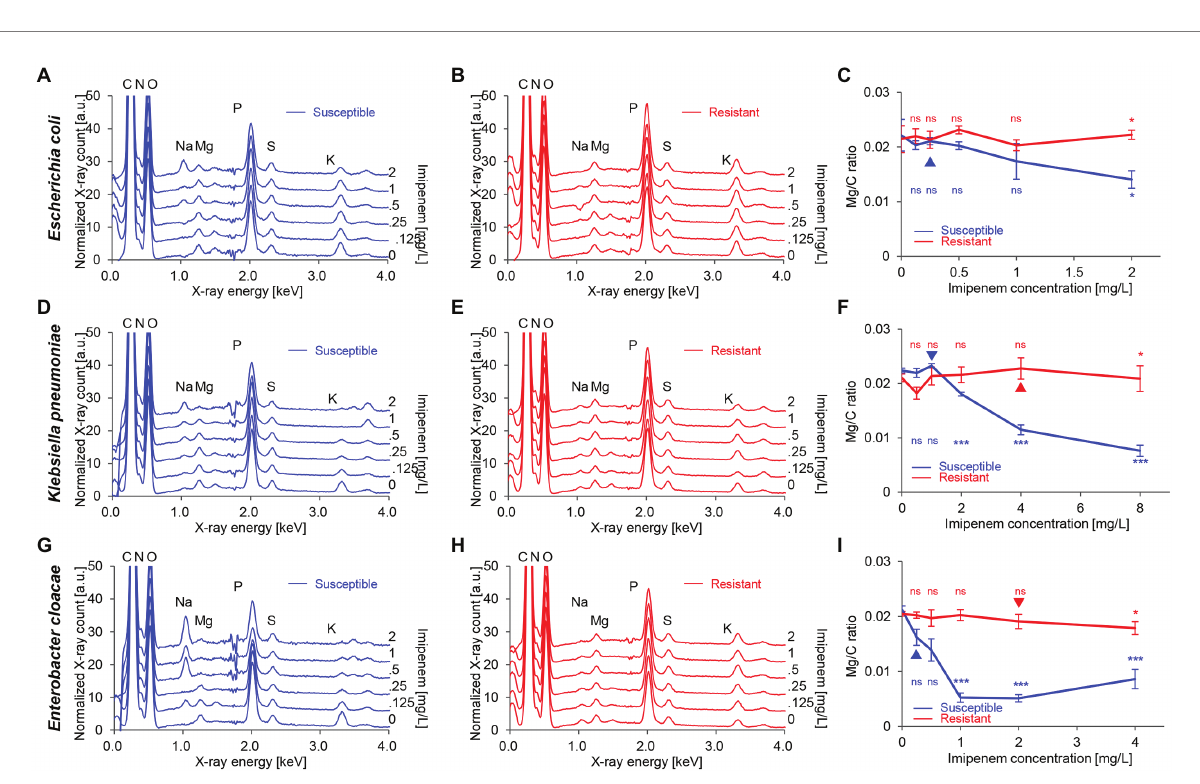
FIGURE 3 EDX spectra and Mg/C ratio of Gram-negative bacilli incubated with imipenem. EDX spectra of (A, D, G) susceptible (Q5586, Q5580 and P9549) and (B, E, H) resistant (P1872, Q2247, and P9548) strains of E. coli , Klebsiella pneumoniae and Enterobacter cloacae , respectively. Each curve represents the average of three spectra taken from the same bacterial deposit. Spectra are offset by 5 (C, F, I) Mg/C ratio of tested strains calculated from the respective EDX spectra. Error bars: standard deviations. Blue and red triangles: MIC of tested strains. * p < 0.01; ** p < 0.001; ** p < 0.0001; (ns): not